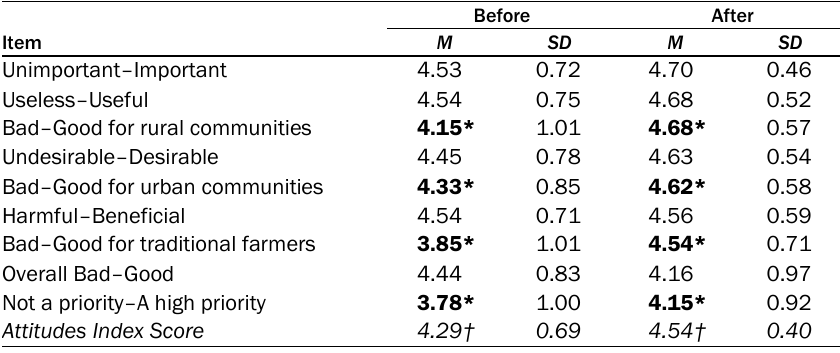
Table 13. Attitudes Toward Local Food Production Before and After COVID-19 ( n =40)